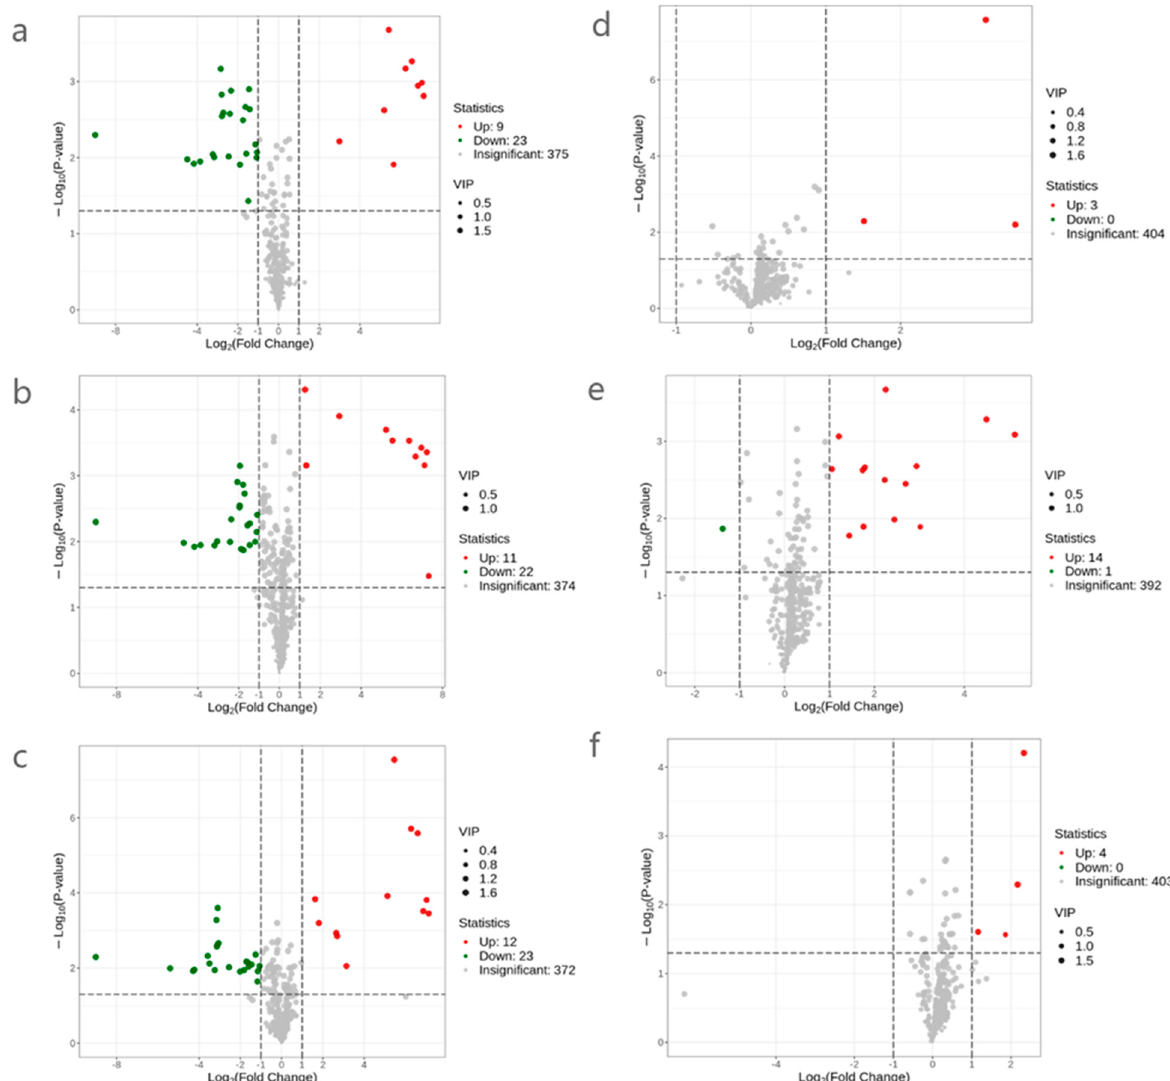
Figure 6. Volcanic map of flavorful metabolites of SRW before and after sterilization. ( a ) Rw-control vs. Rw-past65. ( b ) Rw-control vs. Rw-past75. ( c ) Rw-control vs. Rw-past85. ( d ) Rw-control vs. Rw-pulse A. ( e ) Rw-control vs. Rw-pulse B. ( f ) Rw-control vs. Rw-pulse C.